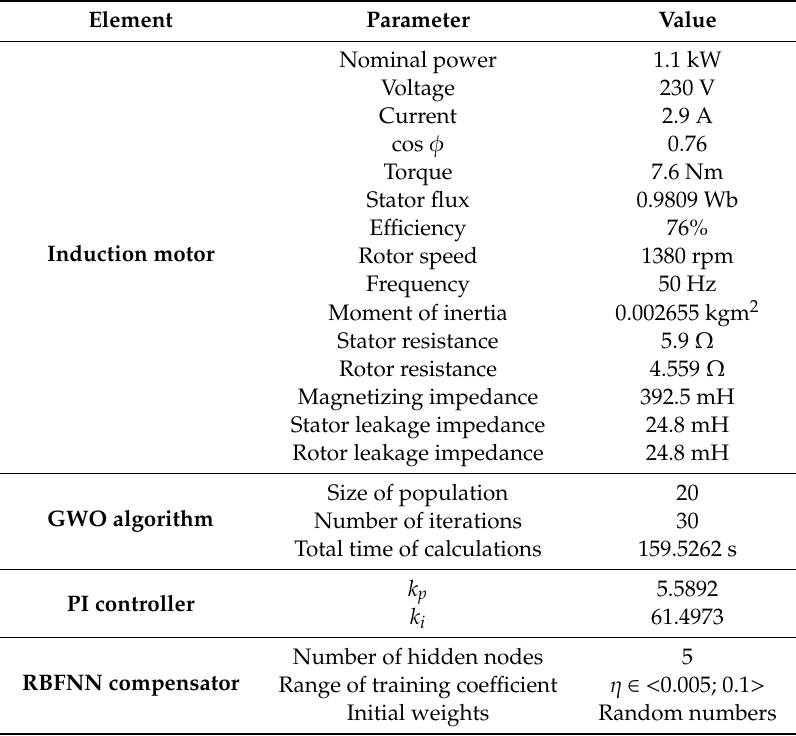
Table 2. Selected parameters of the control